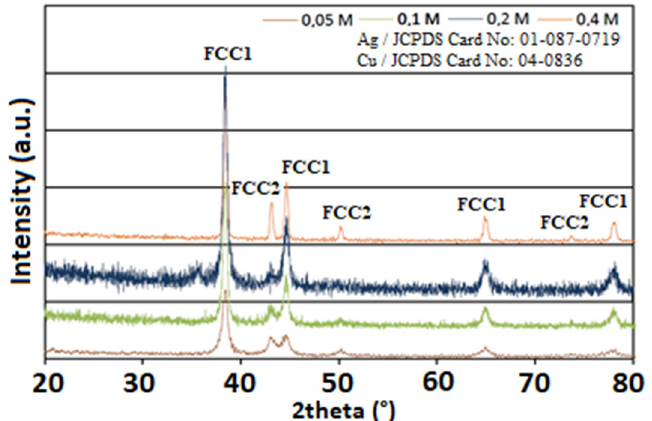
Figure 4. XRD patterns of AgCu nanoparticles (800 ° C, 1.0 L/min H 2 flow rate and frequency of 1.3 MHz). 1.3